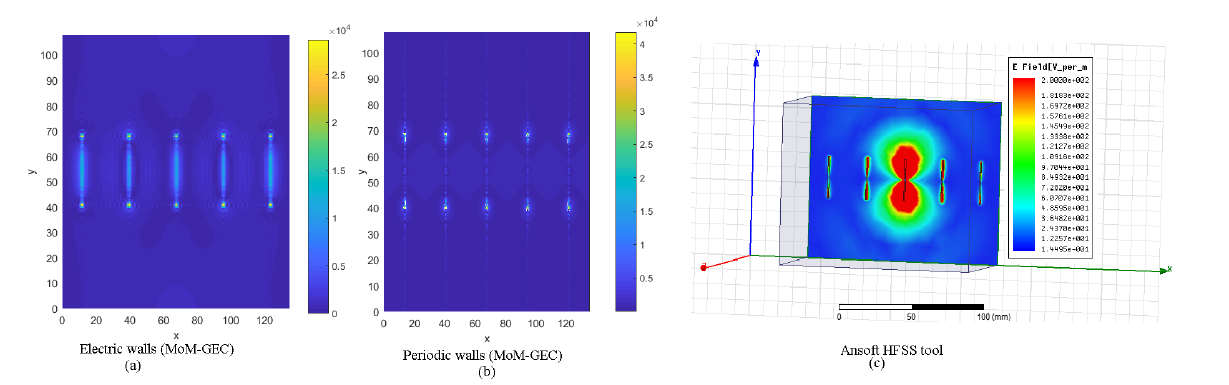
Figure 23. Electric field at the opening of a waveguide composed of 5 coupled planar dipoles (calculation provided by the MoM method and the HFSS software): d x ≈ λ 0